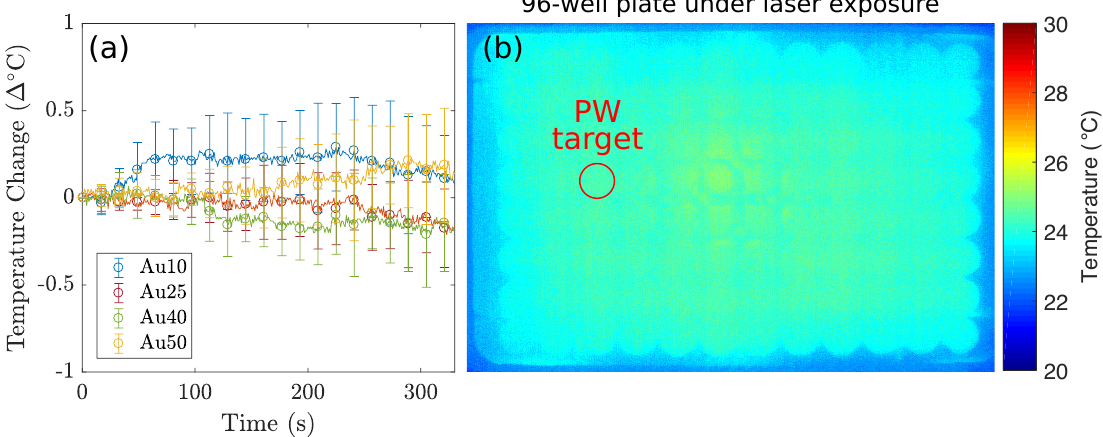
Figure 4. The thermal imaging camera recorded the temperature fluctuations of the 96-well plate containing lung cancer cells incubated with AuNRs. ( a ) The recorded temperature changes of the target well under PW illumination, corresponding to the red circle in ( b ), for 5min for the Au10s (blue), Au25s (red), Au40s (green), and Au50s (yellow) with the media not replaced, and ( b ) A single frame taken with the thermal camera during the PW-PPTT of lung cancer cells containing AuNRs. The red circle indicates the well under PW laser exposure. The data demonstrates that PW lasers do not induce a bulk temperature change regardless of AuNR size. The observed temperature fluctuations in ( a ) are a result of minute room-temperature changes. Note: Due to the limitations of infrared cameras, the displayed temperature measurements represent the temperature of the plastic bottom of the 96-well